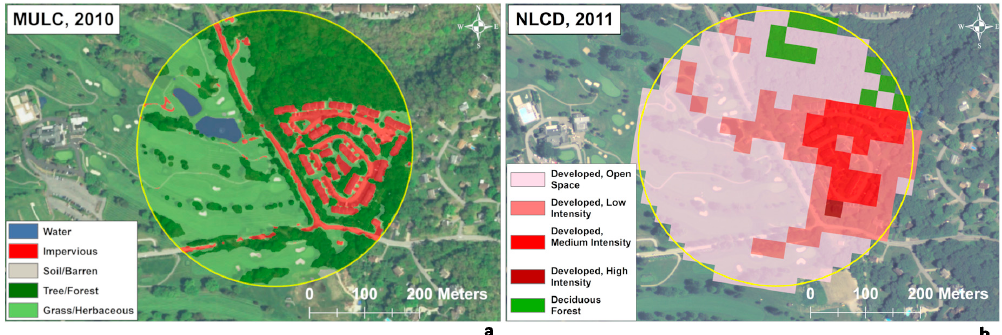
Figure 1. Comparison of spatial scale and level of detail of ( a ) Meter-Scale Urban Land Cover (MULC) (1 m pixel) and ( b ) National Land Cover Dataset (NLCD) (30 m pixel) in a Pittsburgh, PA neighborhood and golf course. Land cover 50% transparency over NAIP